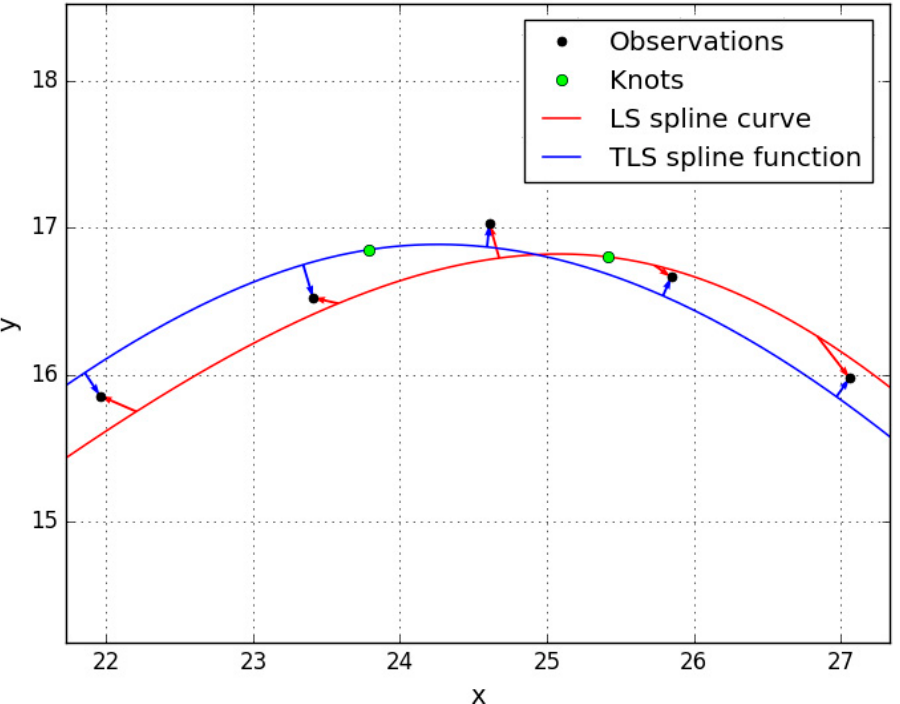
Figure 5. TLS spline function and LS spline curve with location parameter proportional to the chord length.